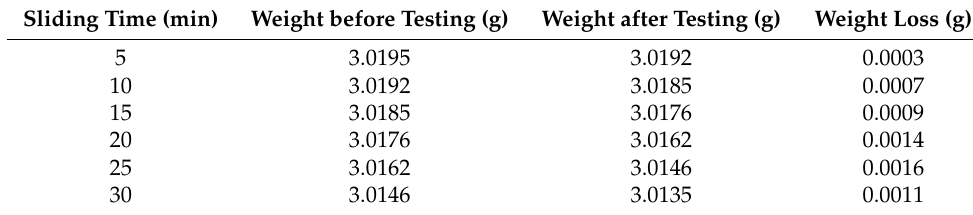
Table 2. Weight loss throughout testing one of the specimens.